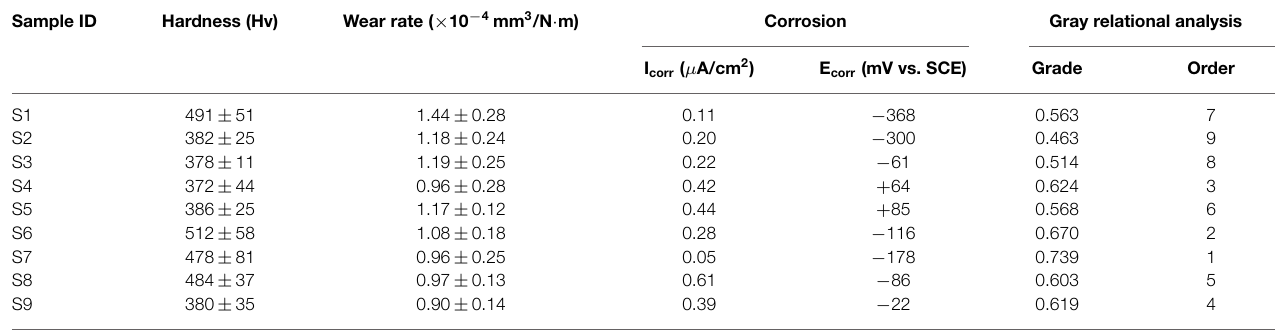
TABLE 2 | Experimentally determined hardness, wear rate, and corrosion data of laser fabricated Co-Cr-Mo alloy . Sample ID